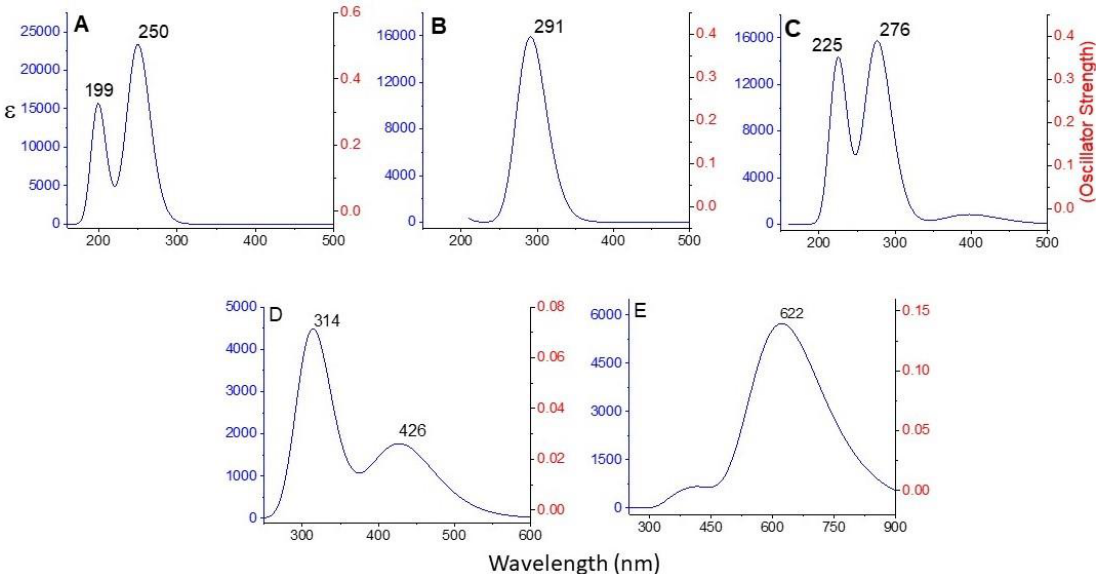
Figure 14. DFT calculated UV-Vis spectra of PA, ChA, DDQ, and their complexes: ( A ) PA; ( B ) ChA; ( C ) DDQ; ( D ) face-to-face I fashion complex of PA with ChA; and ( E ) face-to-face I fashion complex of PA complex with DDQ at the ω B97XD/6-311++G(2d,p) level of theory in acetonitrile solvent system.